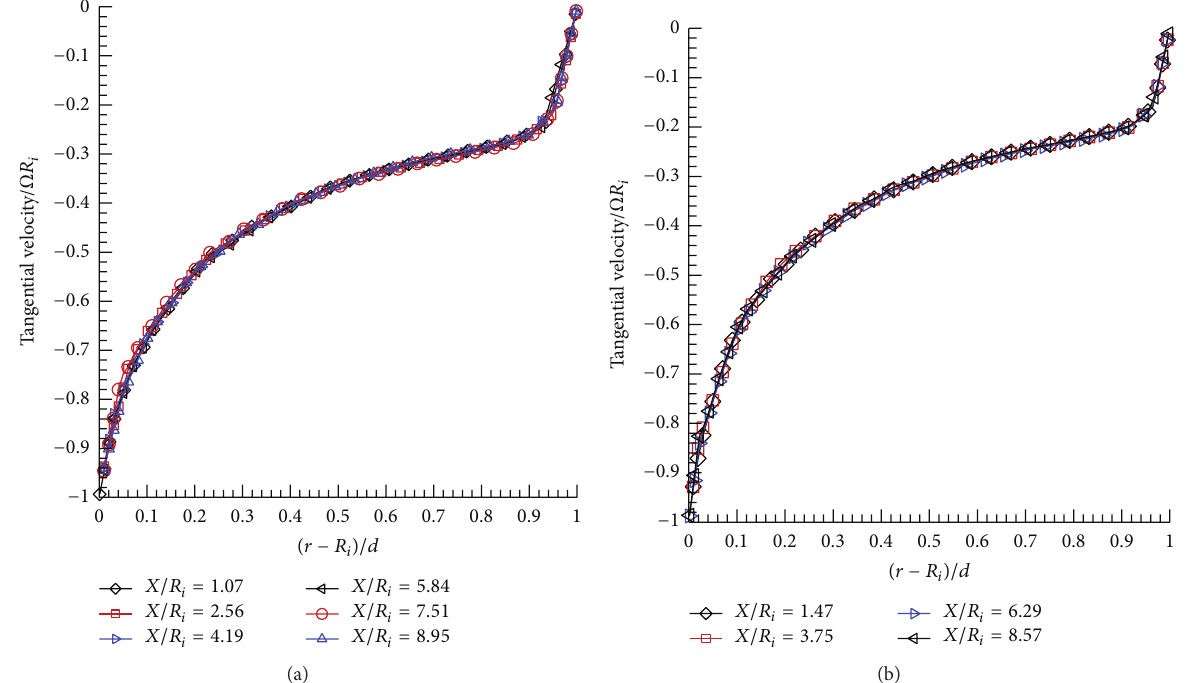
Figure 7: Normalised tangential velocity profiles at the downwell positions on selected axial planes at 𝜃 = −𝜋/2 for the test cases (a) Γ = 11.36 and (b) Γ = 7.81